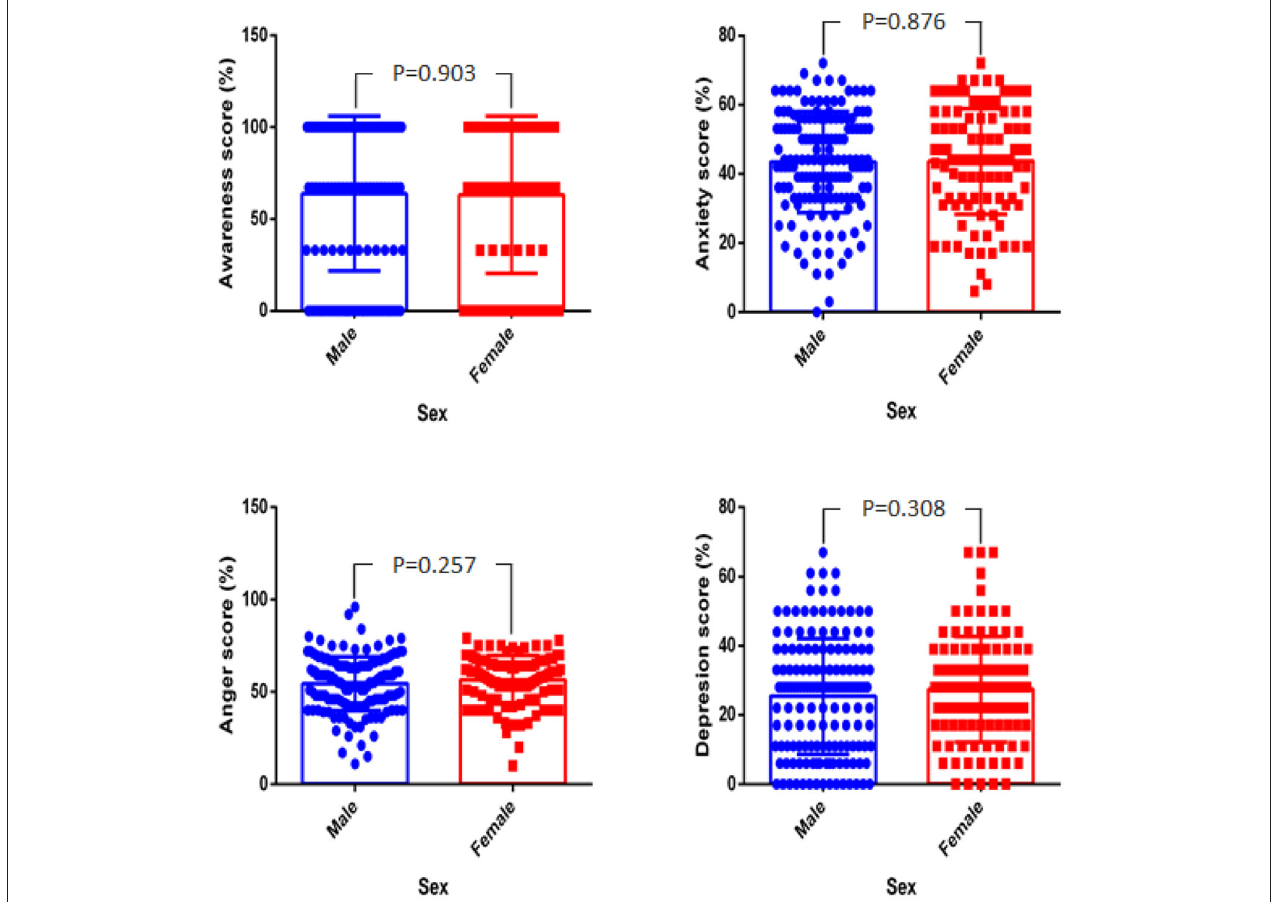
FIGURE 2 | Percentage score difference for awareness, anxiety, anger, and depression between male and